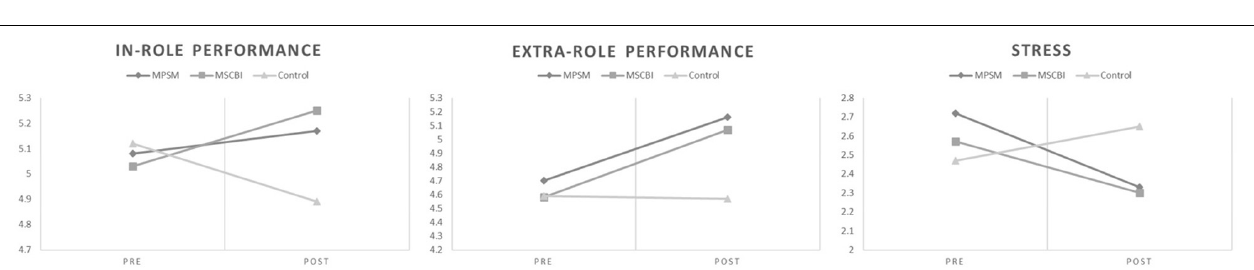
FIGURE 3 | Means estimated for the MBSR group, MPSM group, and control group on pre-intervention and post-intervention time points, for work engagement dimensions with statistically significant interaction effect.